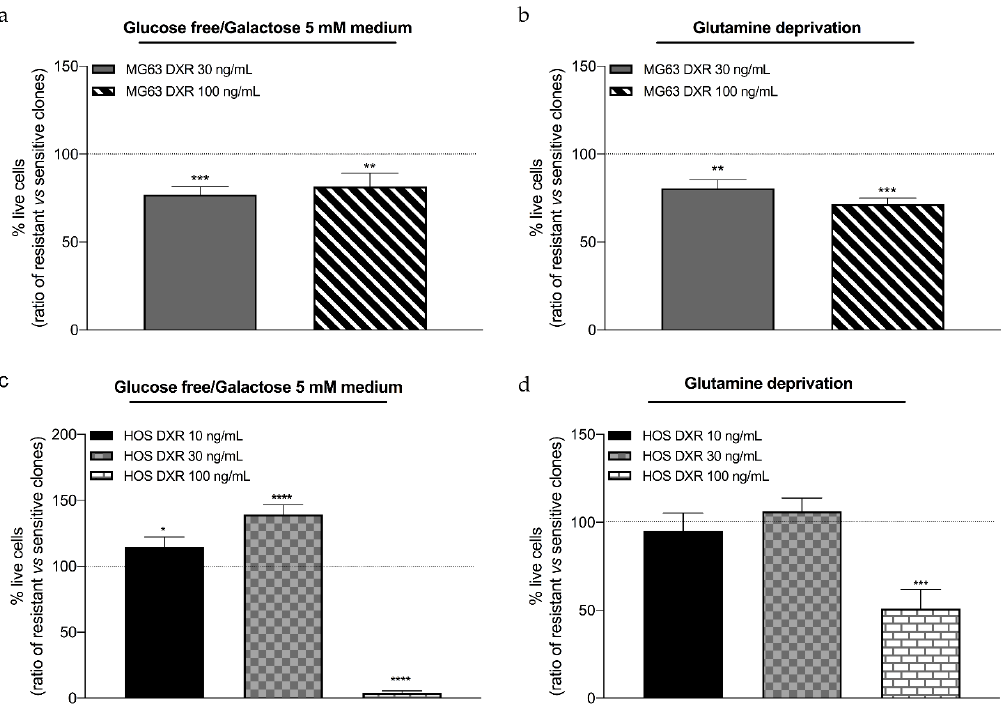
Figure 6. ( a , b ) Evaluation of cell viability by Trypan blue assay in MG63, MG63 DXR 30 ng/mL and MG63 DXR 100 ng/mL cells after 24 h in glucose-free/5 mM galactose medium ( a ) and glutamine deprivation ( b ). The horizontal dotted line refers to normalized untreated cells. ( c , d ) Evaluation of cell viability by Trypan blue assay in HOS, HOS DXR 10 ng/mL, HOS DXR 30 ng/mL, and HOS DXR 100 ng/mL cells after 24 h in glucose-free/5 mM galactose medium ( c ) and glutamine deprivation ( d ). The horizontal dotted line refers to normalized untreated cells. Data represent mean ± SD of four